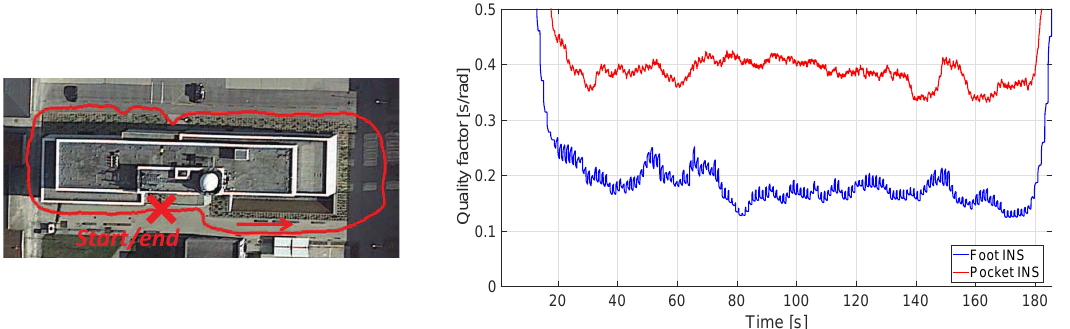
Figure 6. ( Left ) Ground truth of the walk of Figure 4; ( Right ) Quality factor estimated for each of the odometries of Figure 4.